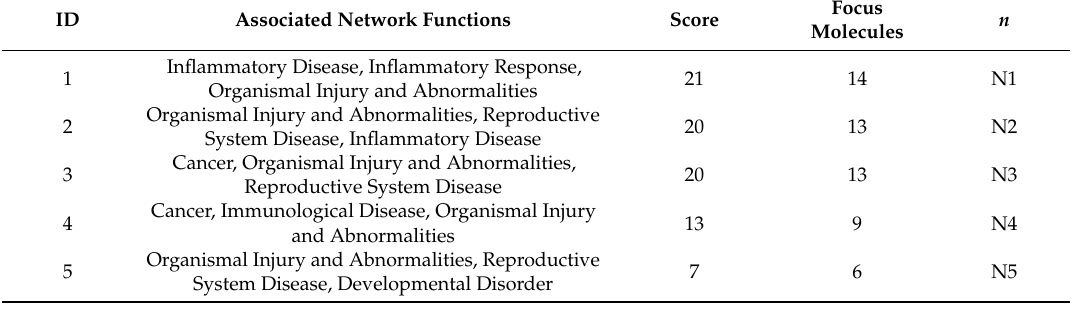
Table 5. The most relevant networks associated with the altered plasma miRNA patterns in colorectal versus healthy controls.